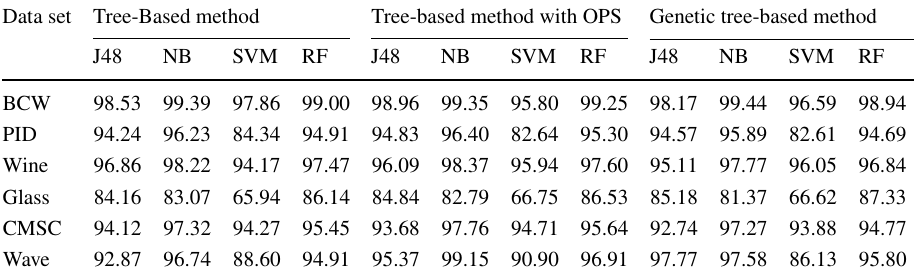
Table 4 Average classification Data set Tree-Based method Tree-based method with OPS Genetic tree-based accuracy (%)